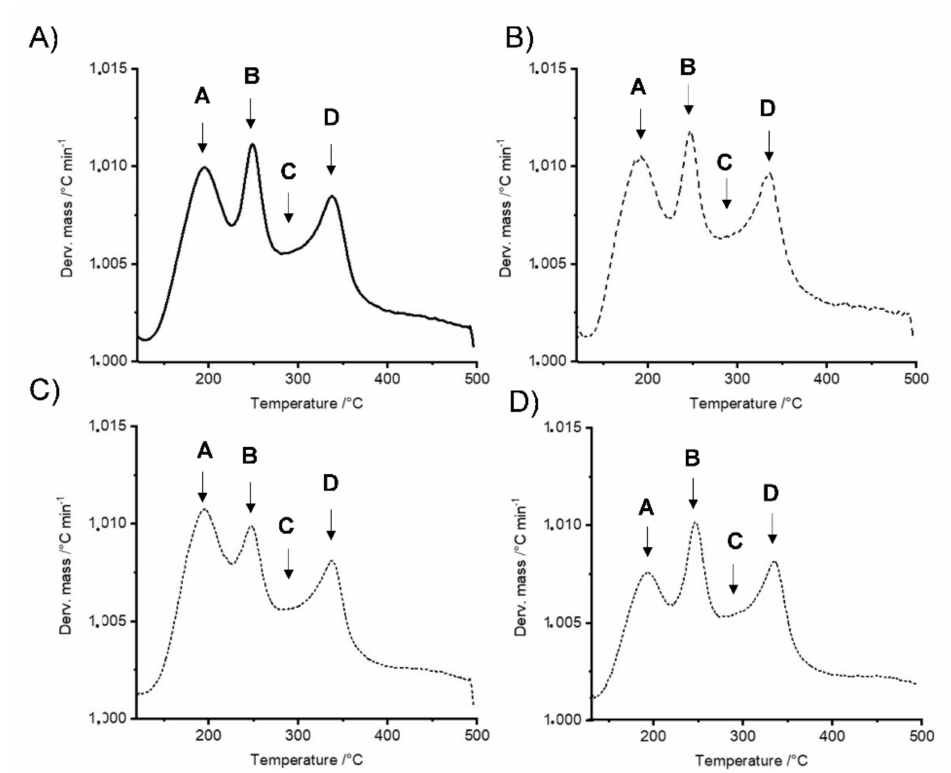
Figure 3. TG/DTG thermogram. ( A ) Control treatment at 0 h; ( B ) control treatment at 48 h; ( C ) auxin treatment at 48 h; ( D ) TIBA treatment at 48